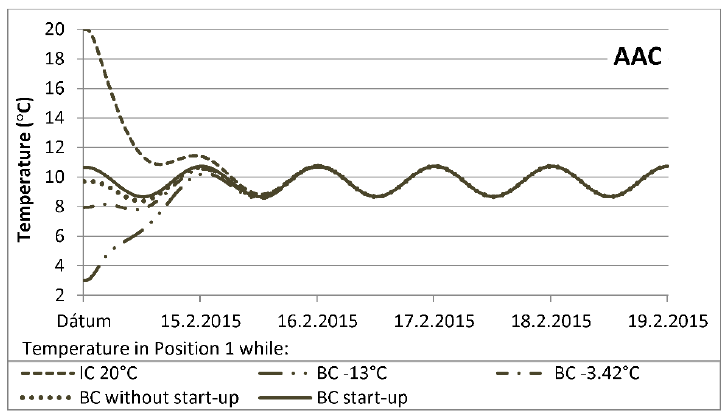
Figure 10. Plotted temperature courses of the simple AAC test wall S2 in Position 1, according to Table 2 and Figure 5b during the chosen time period.